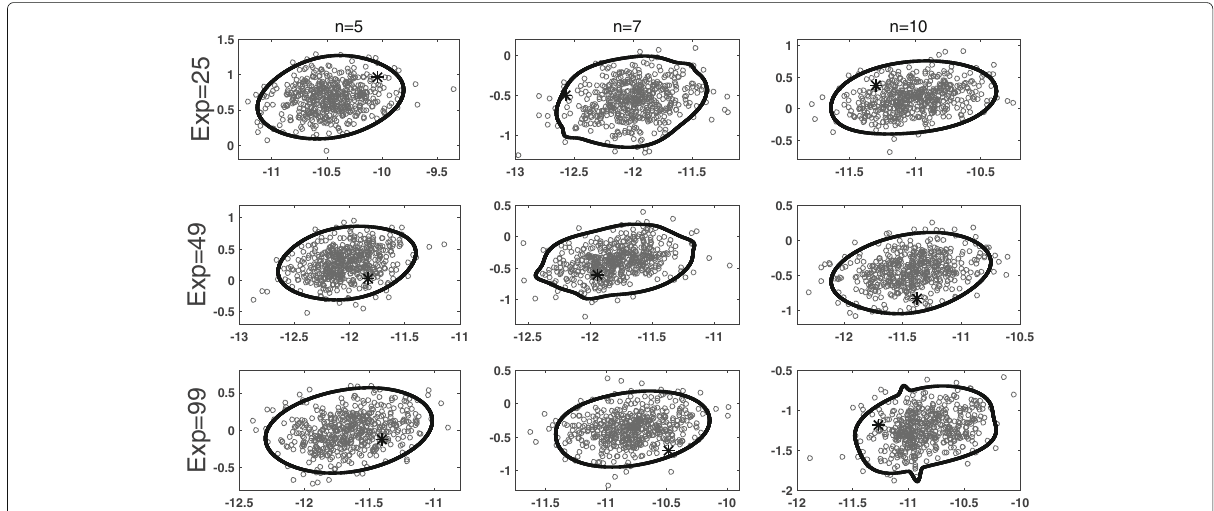
Fig. 3 95% HPD contour sets based on the fitted GMM, for the experiments E = 25,49, and 99. The true simulated value of x n ≡ ( x n ,1 , x n ,2 ) is marked by (cid:10) × (cid:10) in each panel